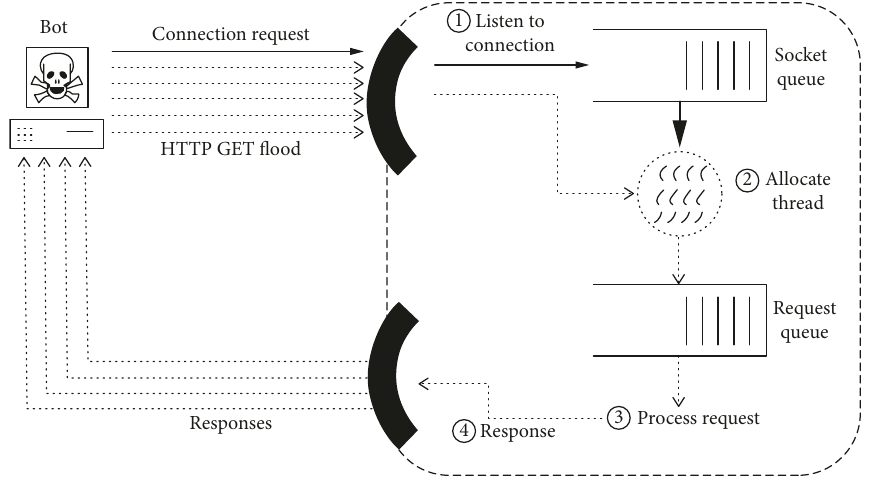
Figure 1: Web server